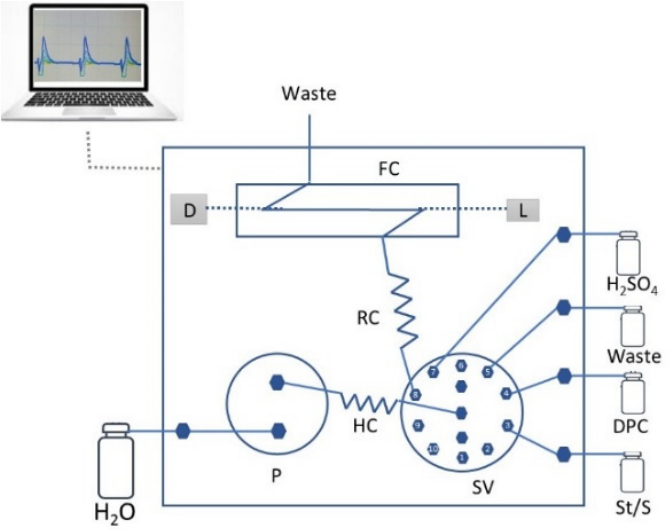
Figure 2. Flow manifold for Cr(VI) determination in water. St/S—standard or sample solution; R1, DPC solution (0.050%); P, syringe pump; SV, selection valve; HC, holding coil (300 cm); RC, reaction coil (50 cm); D, Ocean Optics USB 4000 CCD detector; L, light source; FC, flow cell (50 mm path length); W, waste. Table 5. Protocol sequence for the Cr(VI) determination in recreational waters.